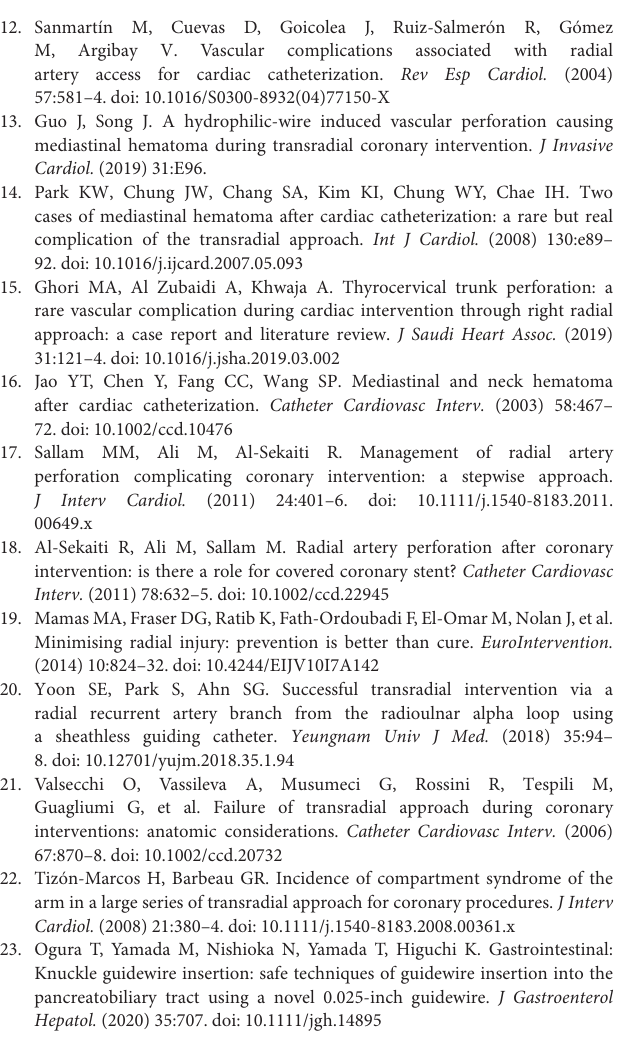
Supplementary Video 3 | Perforation of right internal mammarian artery. Supplementary Video 4 | Covered stent implantation. Supplementary Video 5 | Complete sealing of the